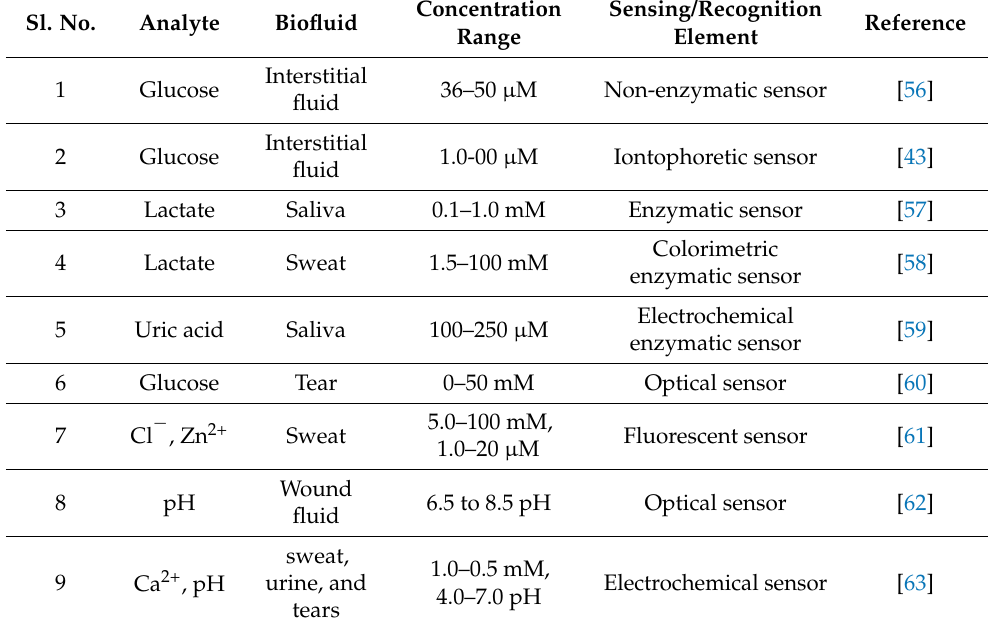
Table 1. The sensing ranges of different analytes in biofluids and the recognition/sensing component used for the